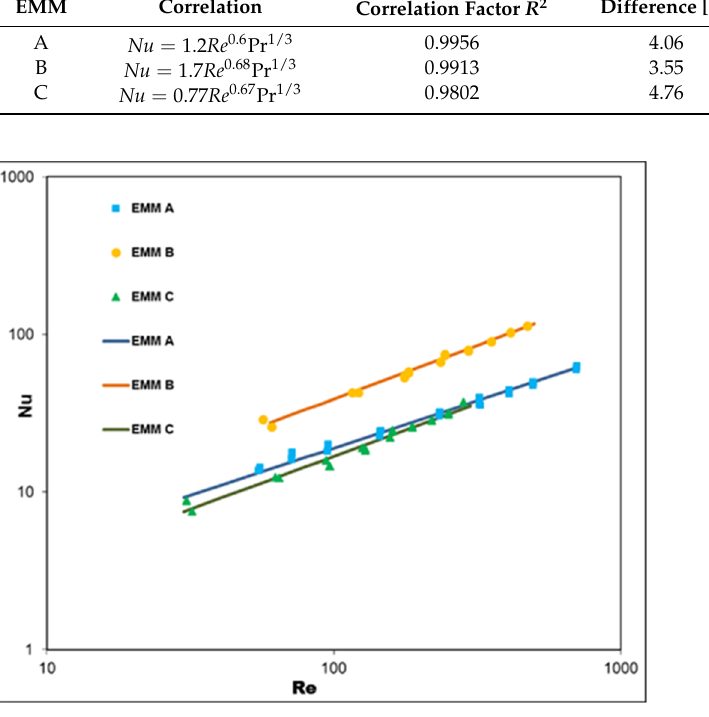
Figure 8. Comparison of Nusselt number derived from experiments (points) and calculated by correlations from Table 4 (lines). correlations from Table 4